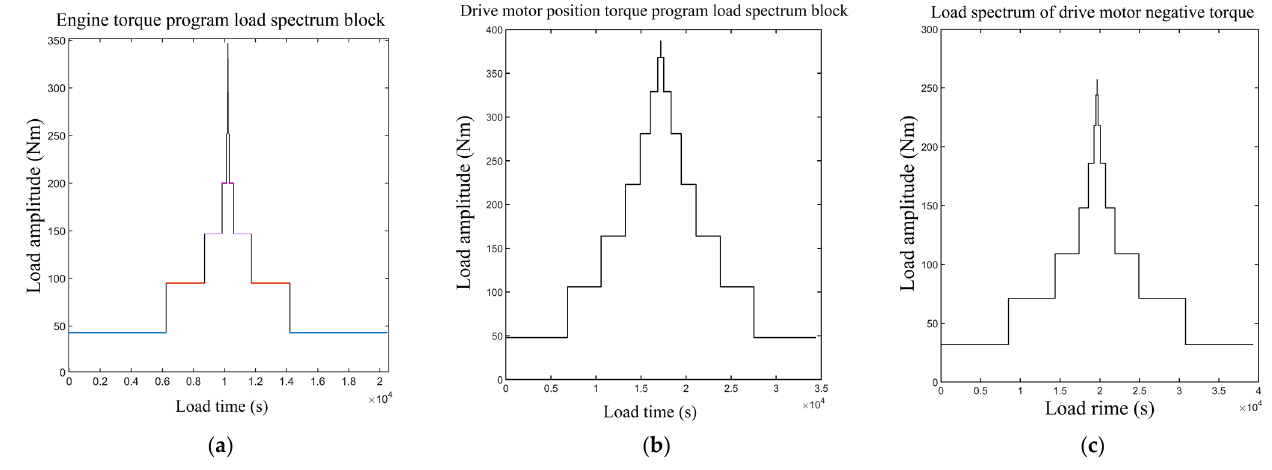
Figure 7. Program load spectrum block of each driving mode under full operating conditions: ( a ) engine torque program load spectrum block, ( b ) drive motor positive torque program load spectrum block, ( c ) drive motor negative torque program load spectrum block.